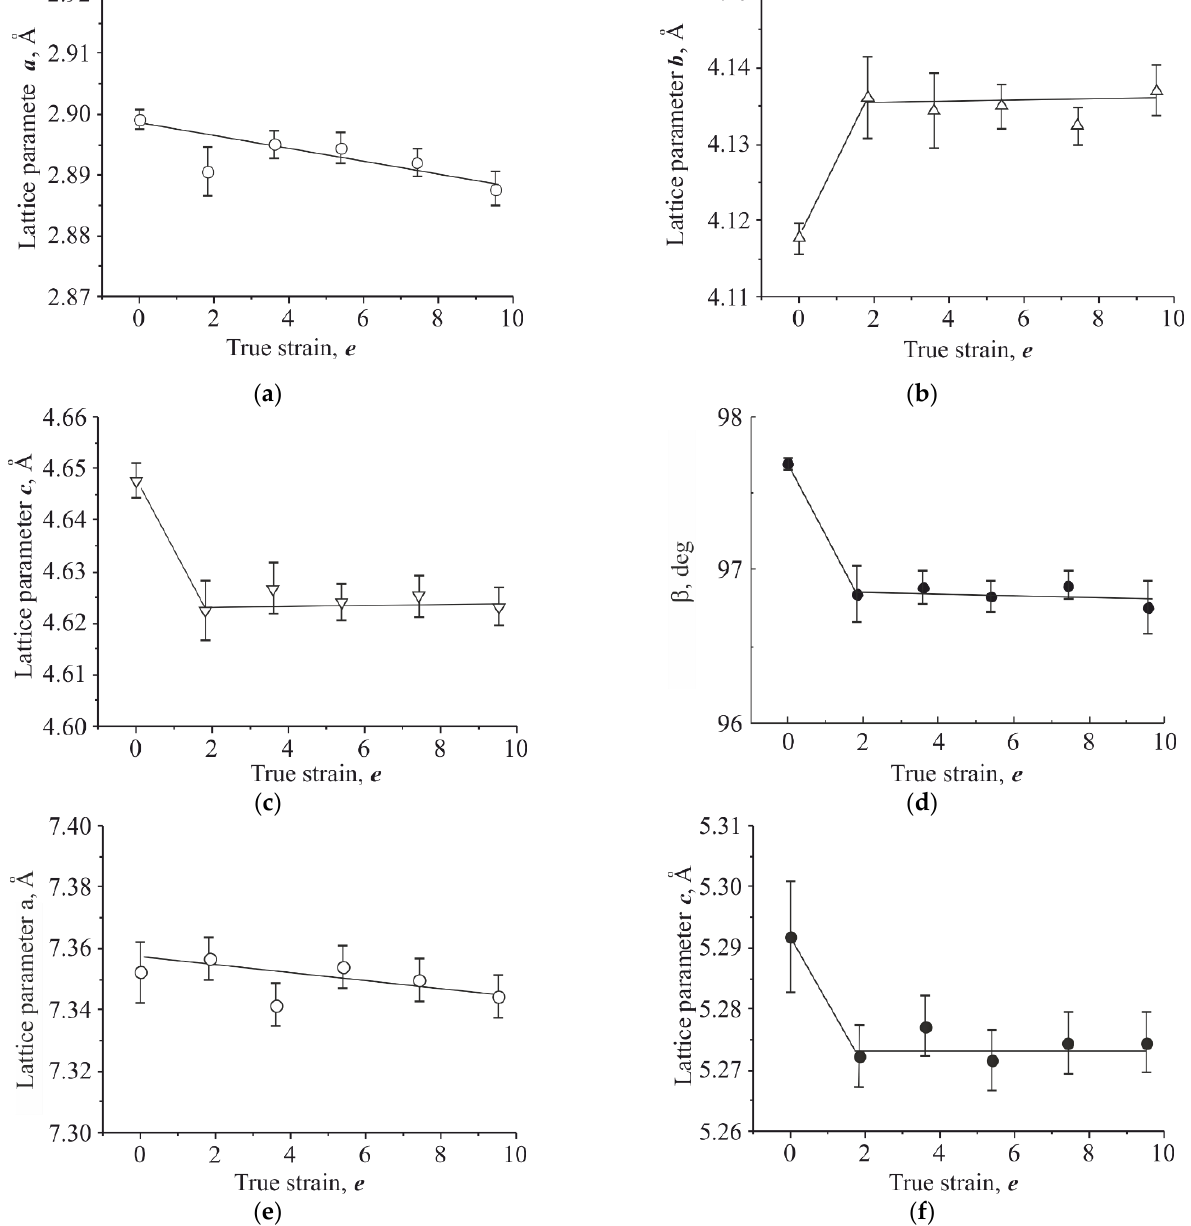
Figure 3. Effect of true abc strain in Ti 49.8 Ni 50.2 on lattice parameters a ( a ), b ( b ), c ( c ), and monoclinic angle β ( d ) of the B19 ’ phase and the lattice parameters a ( e ) and b ( f ) of the R phase.